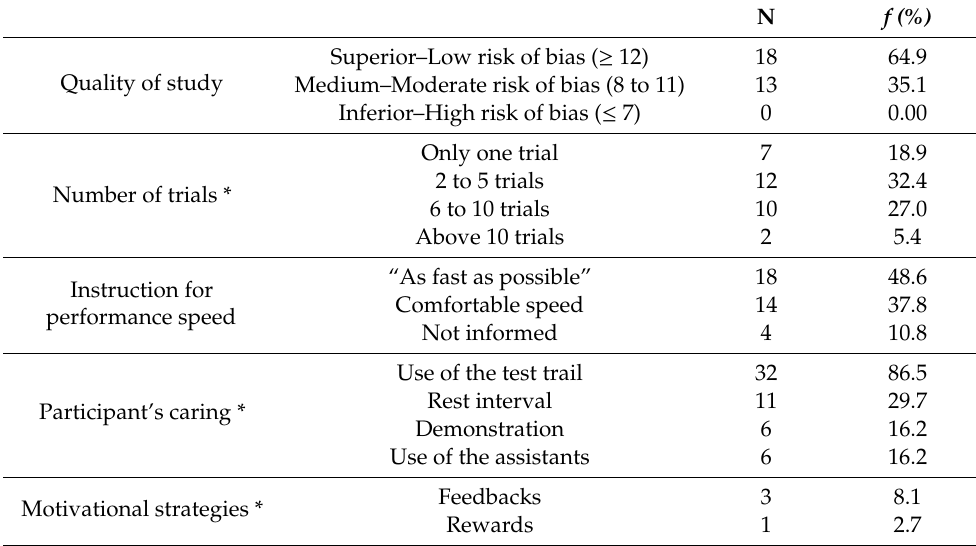
Table 2. Absolute and relative frequencies of the protocols’ characteristics of studies reviewed about the Supine-to-Stand (STS) task ( n =